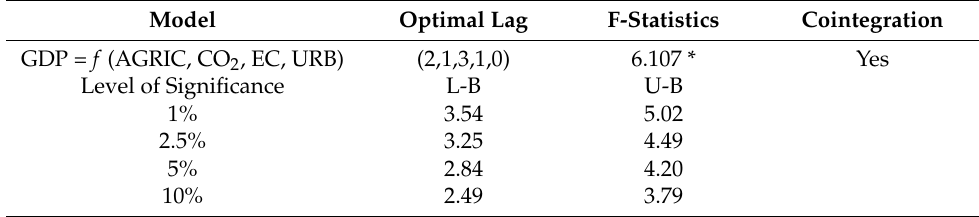
Table 3. ARDL bounds